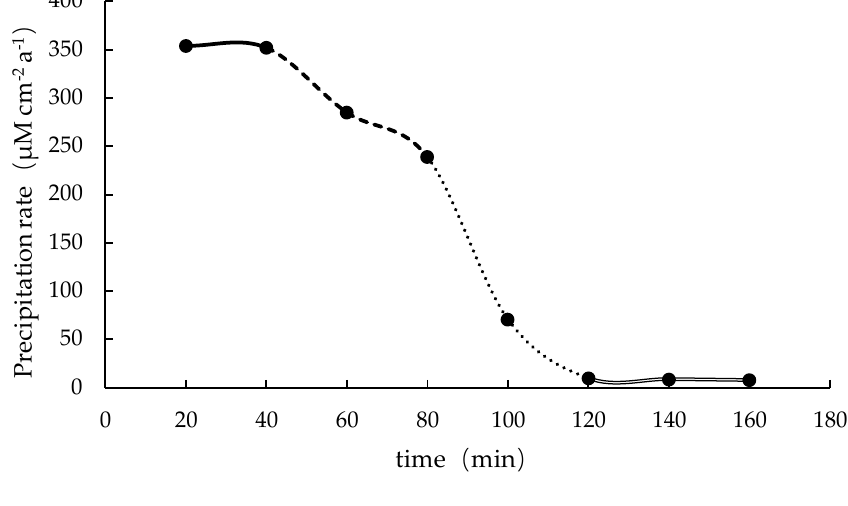
Figure 4. Carbonate precipitation rate at 0 cm of reactor in slow flow scenario.